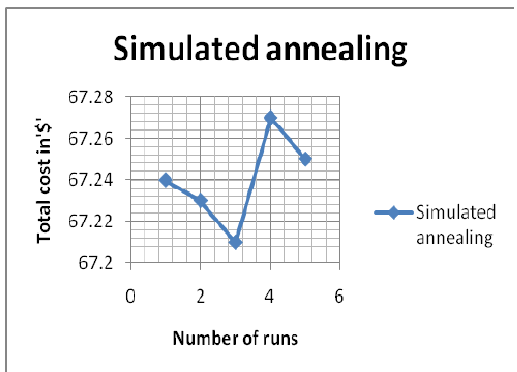
Figure 8 Comparison of total cost with number of trial run for Simulated annealing